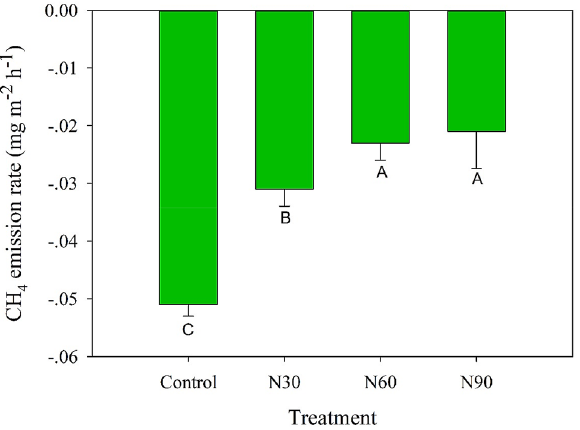
Figure 6. CH 4 emission rate in February 2018 under different N addition